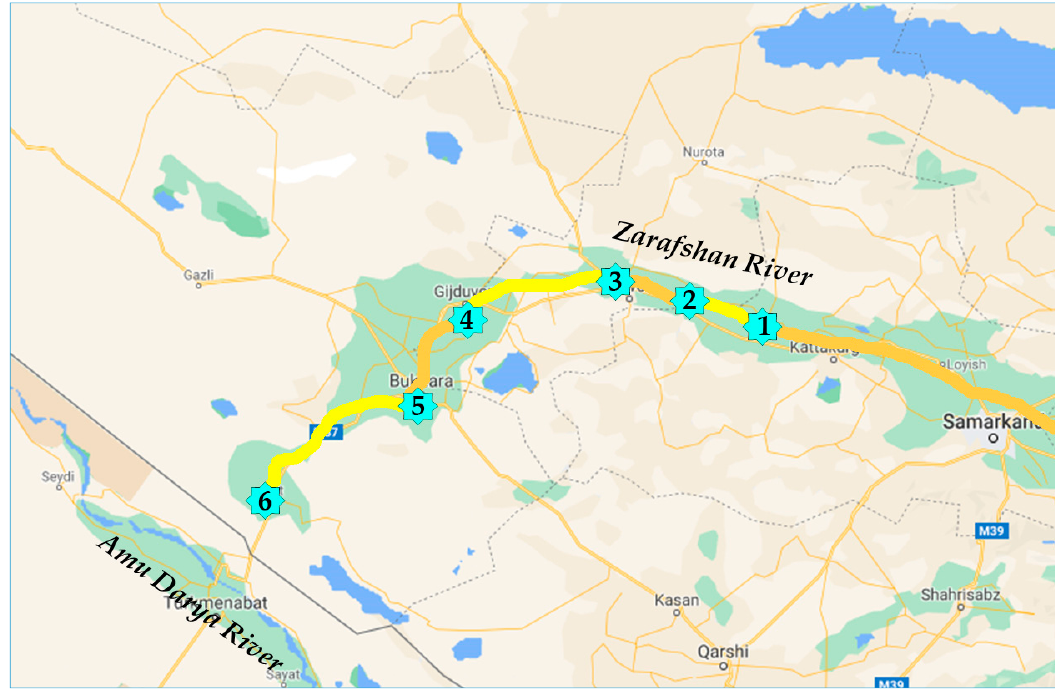
Figure 7. Water Quality map in the Zarafshan River, 2009–2015 on the base of Indices saprobity according Sláde č ek. Color lines as in EU color codes of the Water Quality Classes: yellow—Class 2; orange—Class 3.